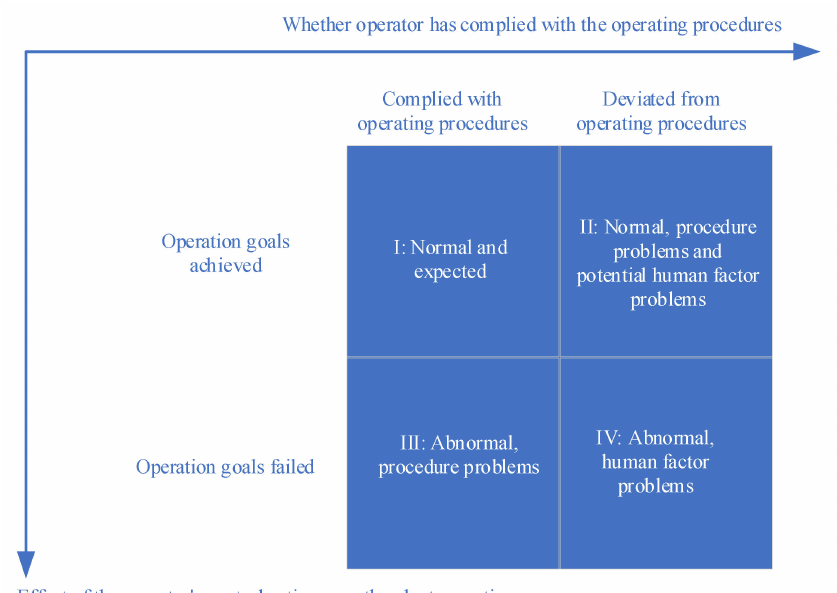
Figure 1. Operator performance deviation